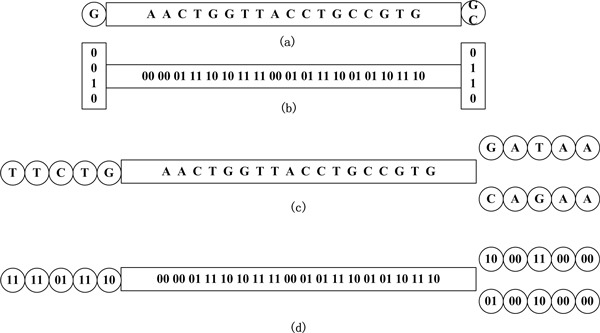
A node with branches in the de Bruijn graph and the sparse k-mer graph. (a) A node with branches in a de Bruijn graph. (b) The binary implementation of (a). (c) A node with branches in a sparse k-mer graph. (d) The binary implementation of (c). The k-mers which are nodes in the graph are squared in the blocks. Neighbouring nucleotides indicating the edges of the graph are circled.